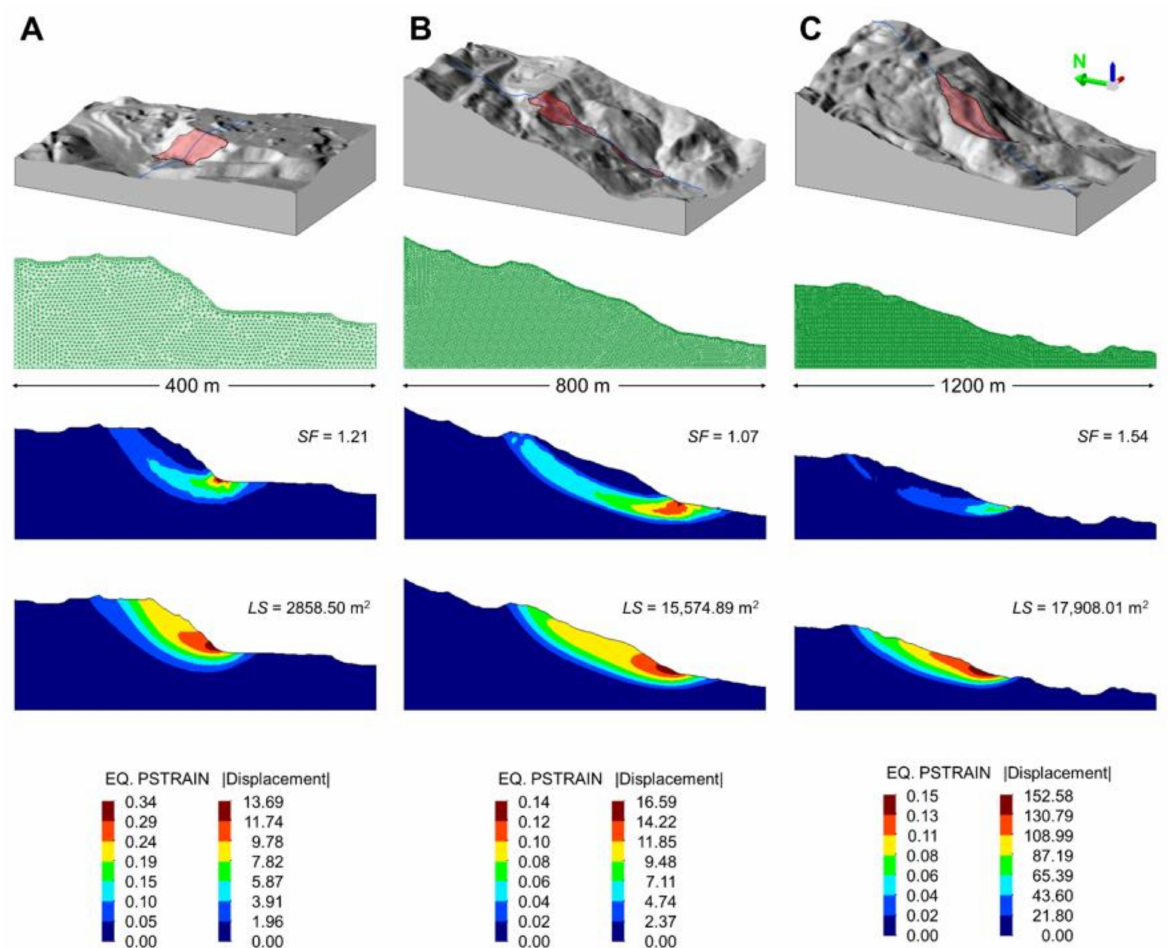
Figure 9. Results of three 2D stability analyses performed using ( A ) 400-, ( B ) 800-, and ( C ) 1200-m long cross-sections derived from three particular active deformation slope units (ADSUs) from the optimal set (ADSU set 18). First row: 3D view of the three ADSUs. The blue solid lines represent each profile trace, the 1200-m long profile trace clipped to the hillshade extent. Second row: finite element meshes corresponding to each profile trace. Third row: equivalent plastic strain contours at failure corresponding to each profile trace. Fourth row: displacement contours (in m) corresponding to each profile trace. The resulting 2D safety factors SF s and 2D landslide sizes LS s are also presented. The legends for the third and fourth rows are shown at the bottom of the